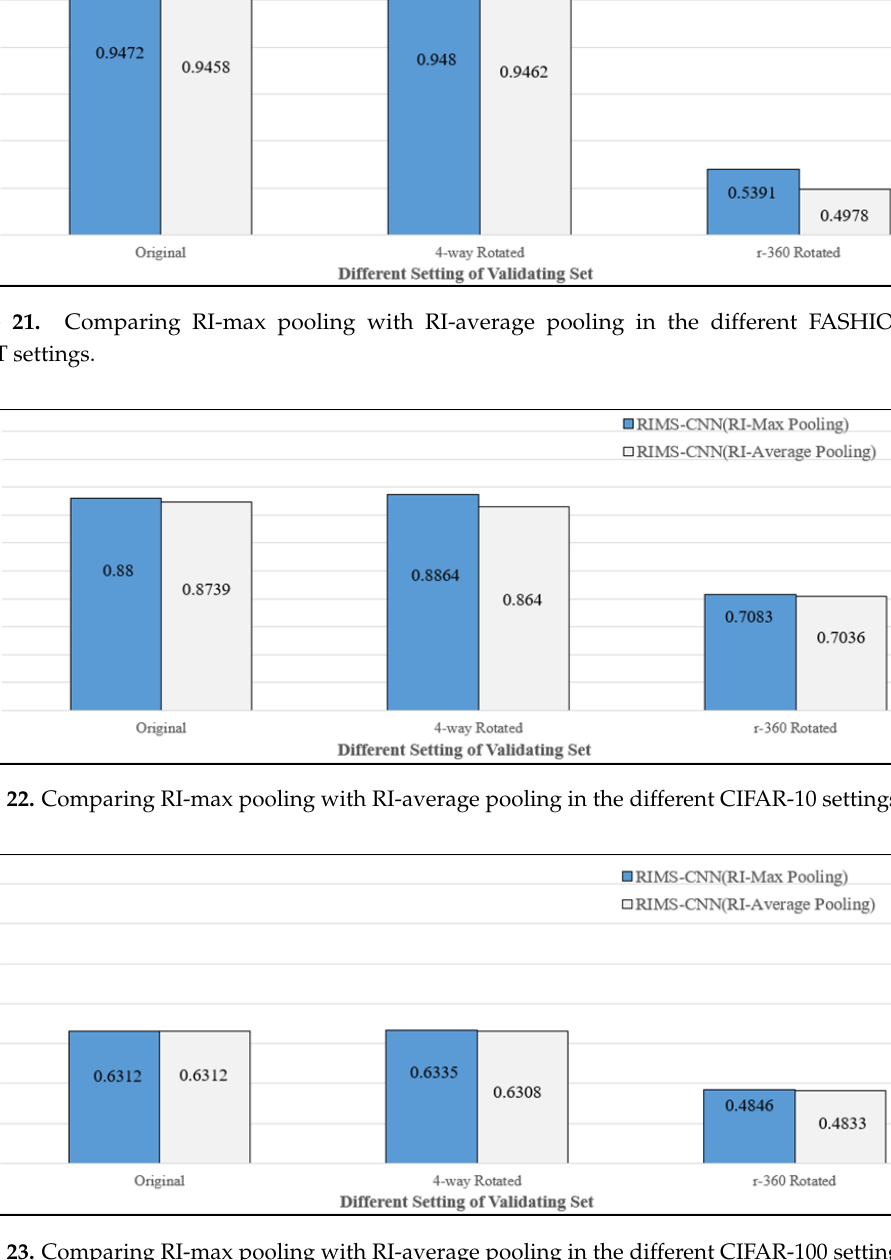
Figure 24. Evaluating different feature-extracting structures on the fixed-angle rotated MNIST. Figure 25. Evaluating different feature-extracting structures on the fixed-angle rotated FASHION- MNIST.